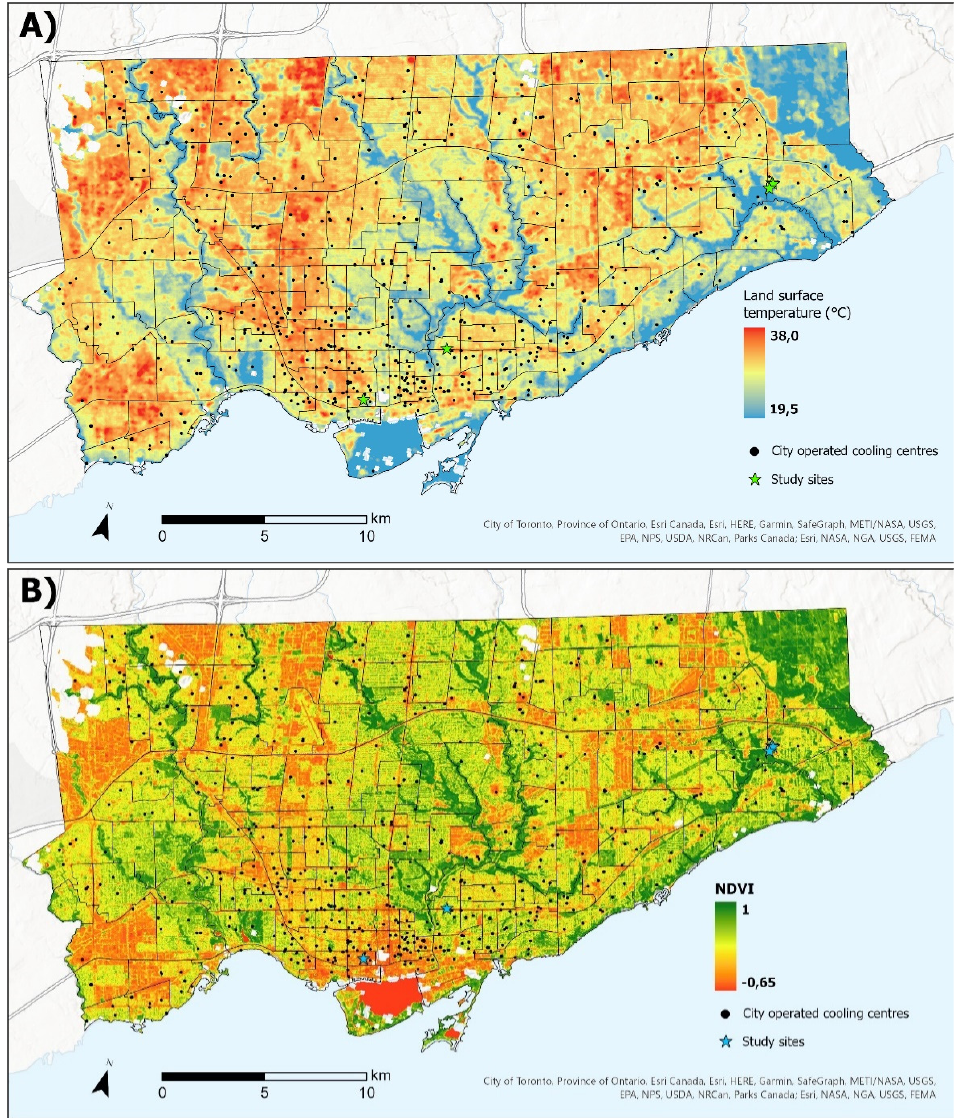
Figure 8. Spatial distribution of LST ( A ) and NDVI ( B ) on 24 August 2016. Mean LST and NDVI values for the 158 neighbourhoods across the city are shown in Figure 9. Such data is extremely important for decision-makers as it can be useful for pri- oritising neighbourhoods for green infrastructure implementation.